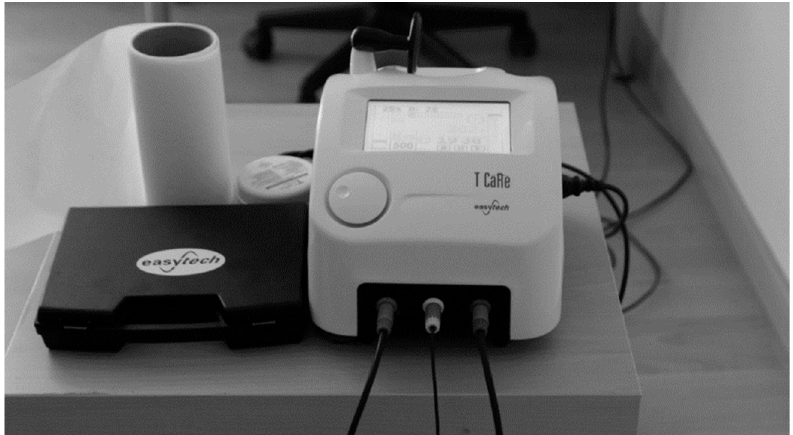
Figure 1. T-Care TECAR ® therapy device. Prepared by the authors.